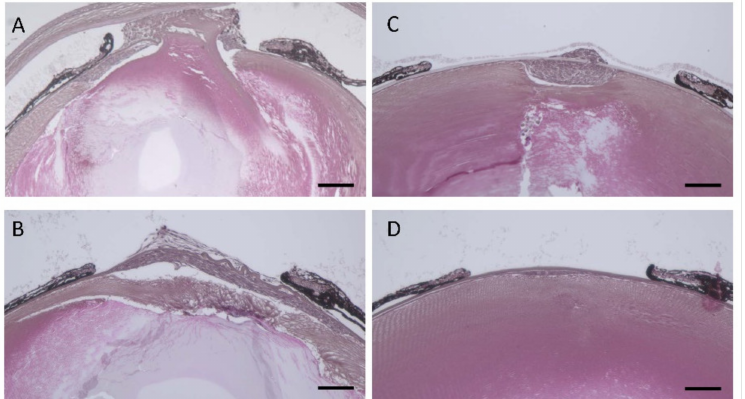
Figure 6. hDCN - Tg suppressed epithelial-mesenchymal transition (EMT) and fibroblastic changes in injured mouse lenses. Paraffin sections of the lenses of WT ( A , B ) and hDCN - Tg animals ( C , D ) with injury at 5 and 10 days were prepared and stained with H & E. Scale bar, 100 µ m. Results are representative of six independent lenses.